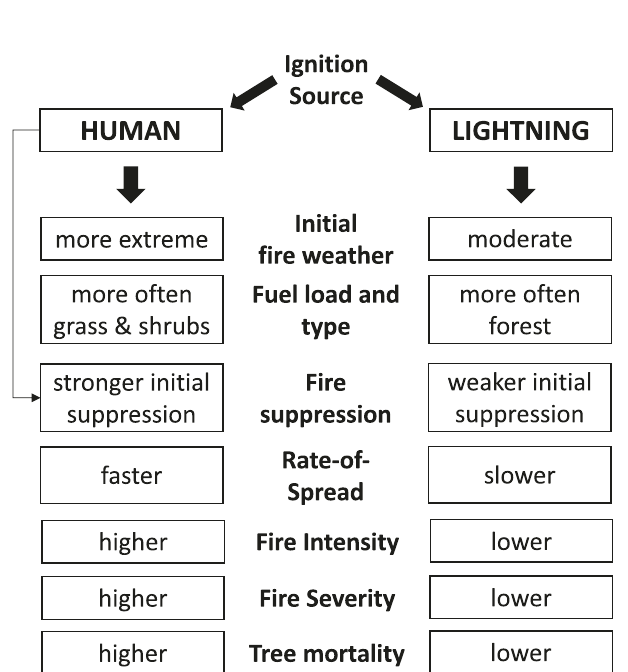
Fig. 4 Conceptual scheme linking ignition type to fi re behavior and post- fi re impact. Ignition source in fl uences the probability of ignitions coinciding with extreme fi re weather, and how this propagates through to fi re behavior, intensity, and resulting ecosystem impacts. Human-caused ignitions occur throughout the year but are often extinguished quickly due to their proximity to people and infrastructure. Hence, human-caused fi res can normally only grow large under more extreme fi re weather conditions, which allows for high initial rate-of-spread that increases the likelihood fi res can escape initial suppression. In contrast, lightning-caused fi res generally coincide with more moderate fi re weather but are often far from any infrastructure or human presence, which limits the effectiveness of initial suppression. As a consequence, human-caused fi res tend to be faster and of higher intensity, which leads to higher fi re severity and tree mortality when compared to lightning-caused fi